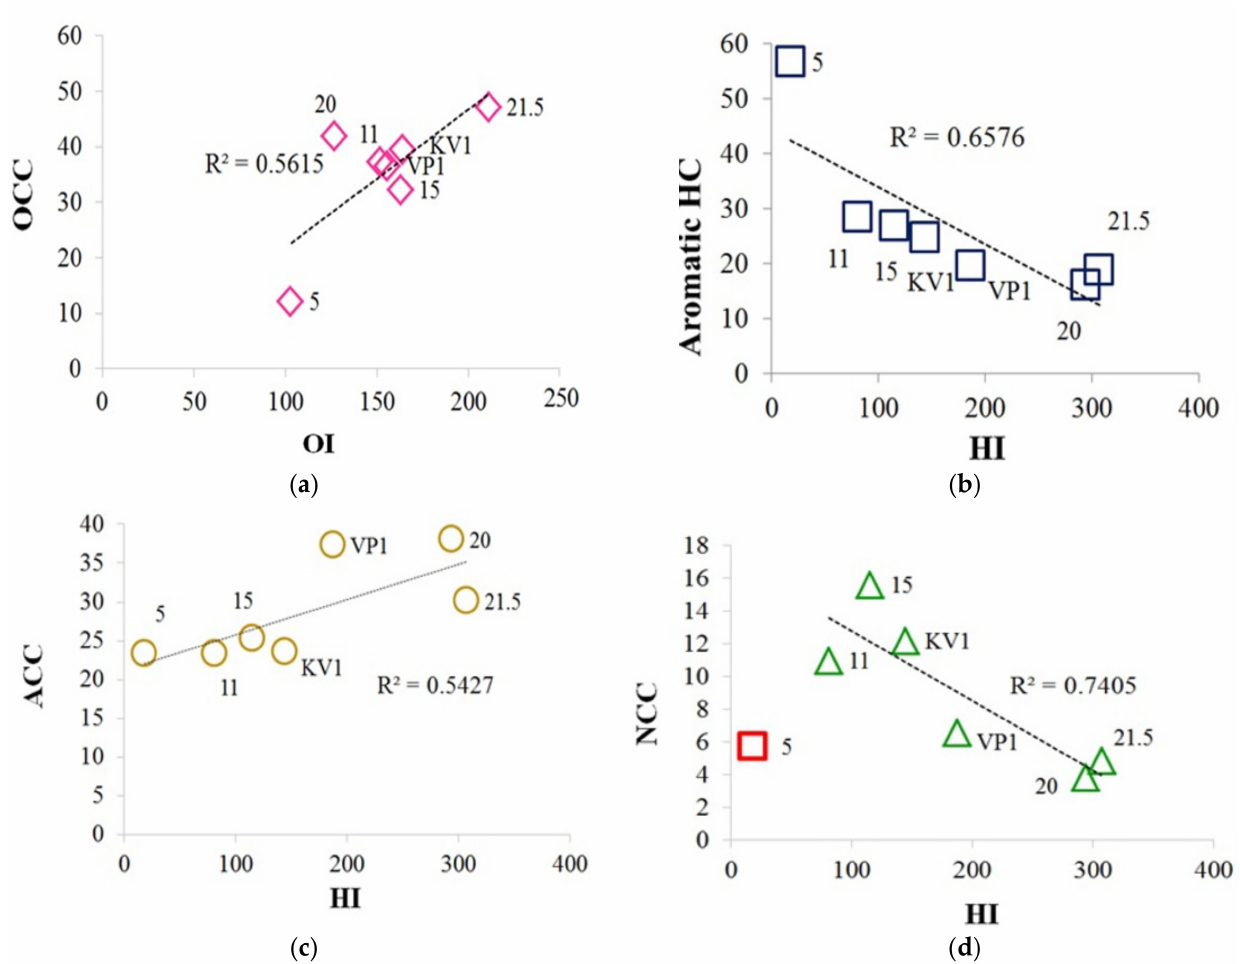
Figure 13. Correlations between the composition of the Py-GC-MS pyrolysis products and the Rock-Eval parameters: ( a ) Relationship between the oxygen-containing compounds (OCC) and the oxygen index (OI); ( b ) relationship between the content of the aromatic HC and the hydrogen index (HI); ( c ) relationship between the aliphatic-containing compounds (ACC) and the hydrogen index (HI); ( d ) relationship between the nitrogen-containing compounds (NCC) and the hydrogen index (HI); sample “5” falls out from the